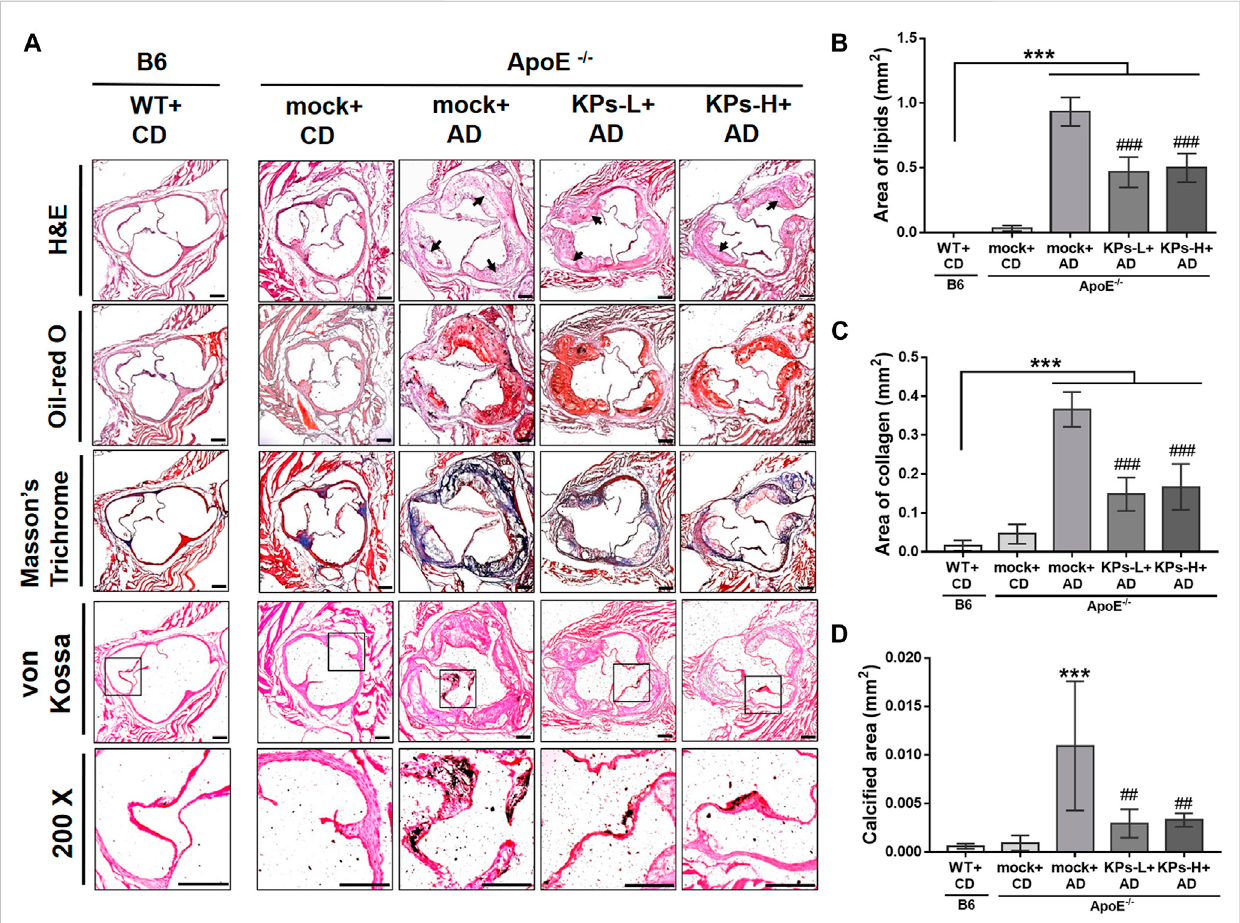
FIGURE 2 KPs attenuate the development of atherosclerotic vascular calci fi cation in aortic roots. (A) Representative images of H&E, Masson ’ s trichrome, and von Kossa staining at the aortic roots. Arrows indicate aortic valves. (B – D) Area quanti fi cation of lipids, collagen, and calci fi cation within the aortic roots. Scale bar: 200 μ m. Statistical signs ( n = 6): *** p < 0.001 vs. WT + CD/B6, and ## p < 0.01, ### p < 0.001 vs. mock + AD/ ApoE − / −